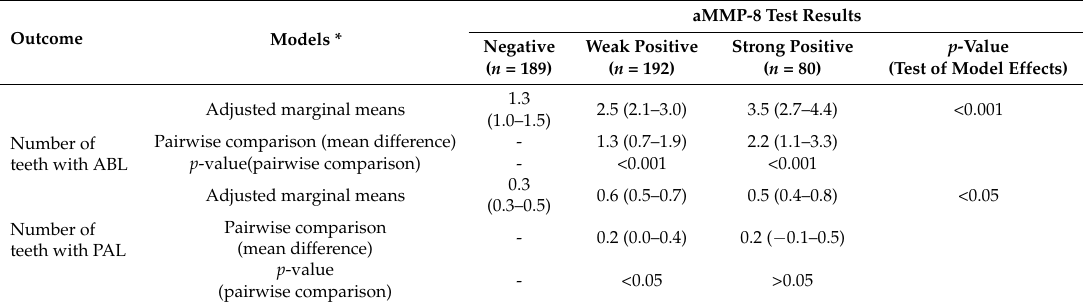
Table 3. Association between aMMP-8 test results and marginal alveolar bone loss or periapical lesions.